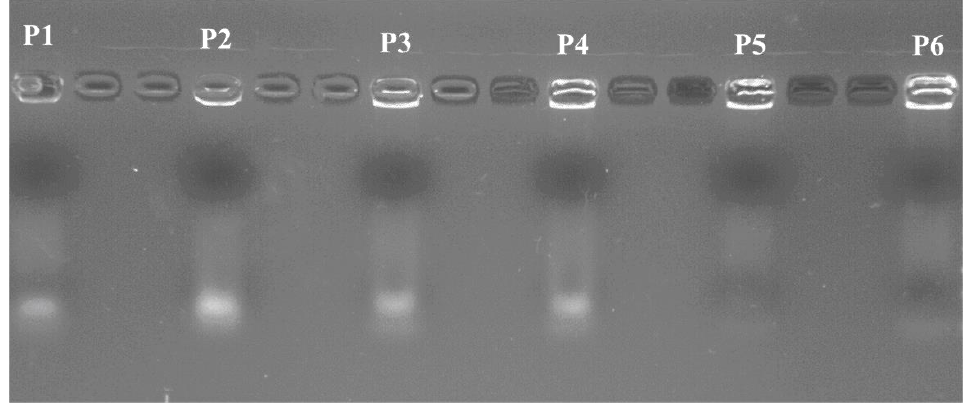
Figure 4. Gel retardation assay of the ternary polyplexes P1–P6, which possess different N/P ratios.